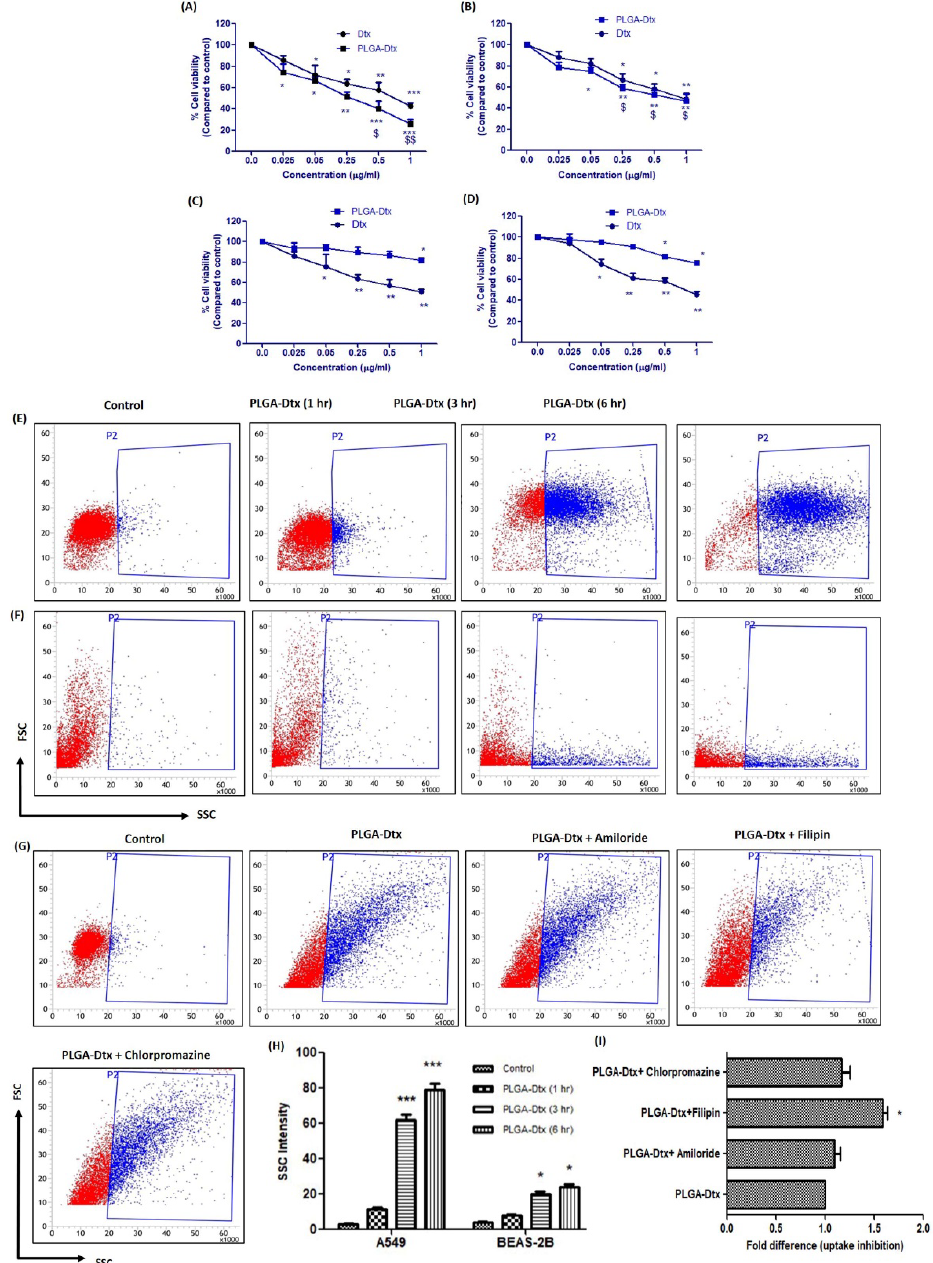
Figure 2. In vitro cellular cytotoxicity and uptake assay. ( A ) In vitro cytotoxicity of free Dtx and PLGA-Dtx NPs against A549 cancer cells; ( B ) PBMCs derived from lung cancer patients; ( C ) BEAS-2B cells; ( D ) PBMCs derived from healthy donors; Flow cytometer analysis of in vitro cellular uptake of PLGA-Dtx nanoparticles for 3 and 6 h in ( E ) A549 cancer cells; ( F ) BEAS-2B cells; ( G ) effect of pharmacological inhibitors on uptake of PLGA-Dtx in A549 cancer cells; ( H ) graphical representation of in vitro cellular uptake ( I ) graphical representation of effect of pharmacological inhibitors.